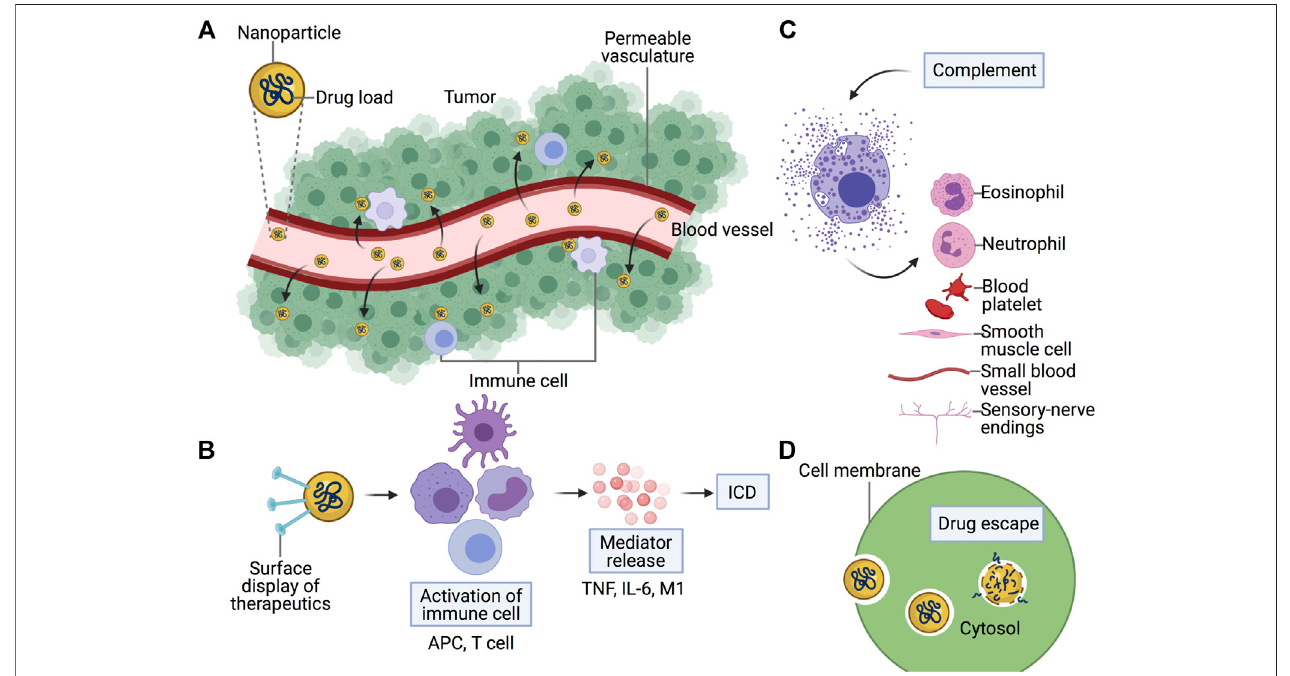
FIGURE 2 | Immune responses of cancer nanomedicine. Combination of nanoparticles with cancer drugs induce a different effect towards immune responses comparedtofreedrugsintermsof (A) Normalizationofthetumormicroenvironment, (B) Immunogenicity, (C) Hypersensitivity,and (D) Tolerability. (A) Duetopermeable vasculature in the tumor microenvironment, nanomedicine is designed with an enhanced permeability and retention (EPR) effect to enhance the effect of the drug. (B) Uponintroductionofnanomedicine,immunecellssuchasantigen-presentingcells(APC)andTcellspromotethereleaseofmediatorsandinduceimmunogenic cell death (ICD) pathways. (D) Nanomedicine is demonstrated to increase the tolerability of drugs due to targeted release into tumor cells. (C) However, nanomedicine could provoke the immune response to release complements responsible for hypersensitivity reactions. Created with